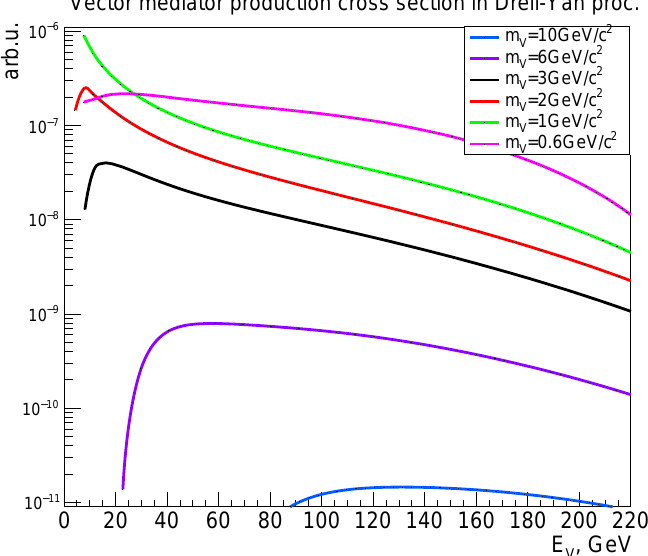
Figure 3. Dependence of the differential cross section of the Drell-Yan process on the energy of the generated mediator (dark photon) for different masses of the